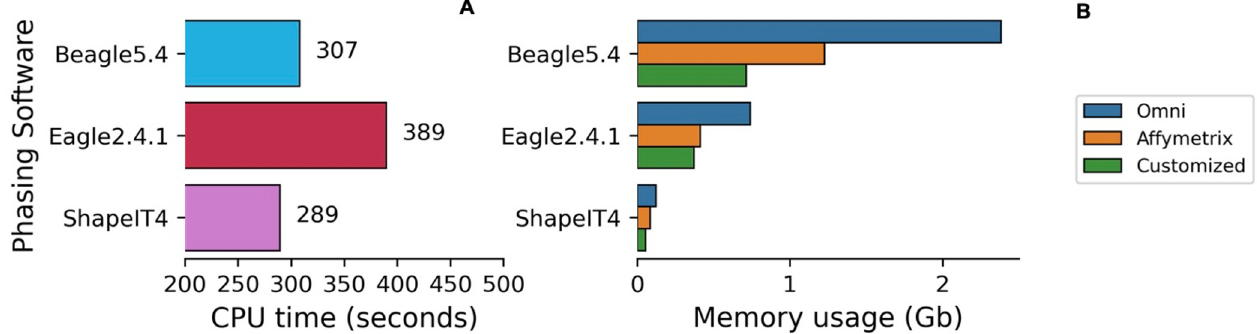
Fig 6. CPU run time and memory usage of phasing software using chip Omni, Affymetrix and Customized. Average run time for phasing (6A). Average memory usage for phasing (6B) in chips data.